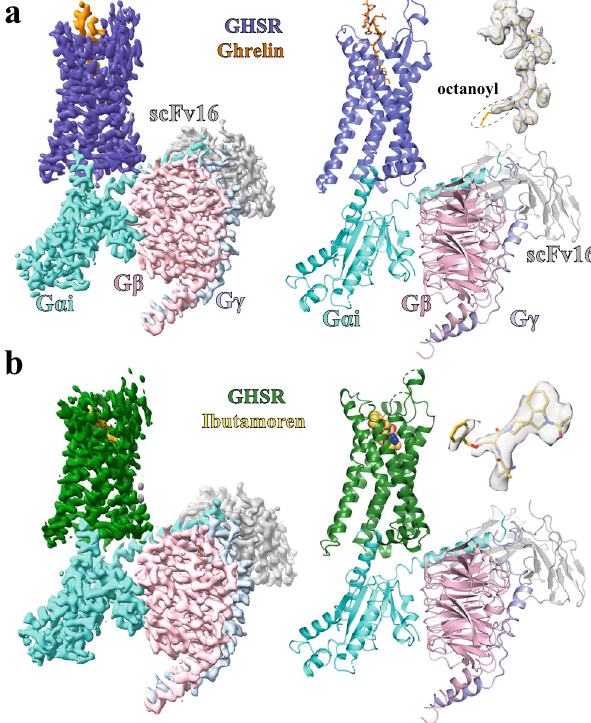
Fig. 1 Overall structures of the GHSR-G i complexes. a , b Cryo-EM density maps of the complex with ghrelin (orange) and ibutamoren (yellow) and overall structures. GHSR bound to ghrelin and ibutamoren is colored in blue and green, respectively. G α i , G β , and G γ subunits are colored in cyan, pink, and light blue, respectively. ScFv16 is colored in gray. The density maps of the two agonists are shown in light gray. The octanoyl group in ghrelin is